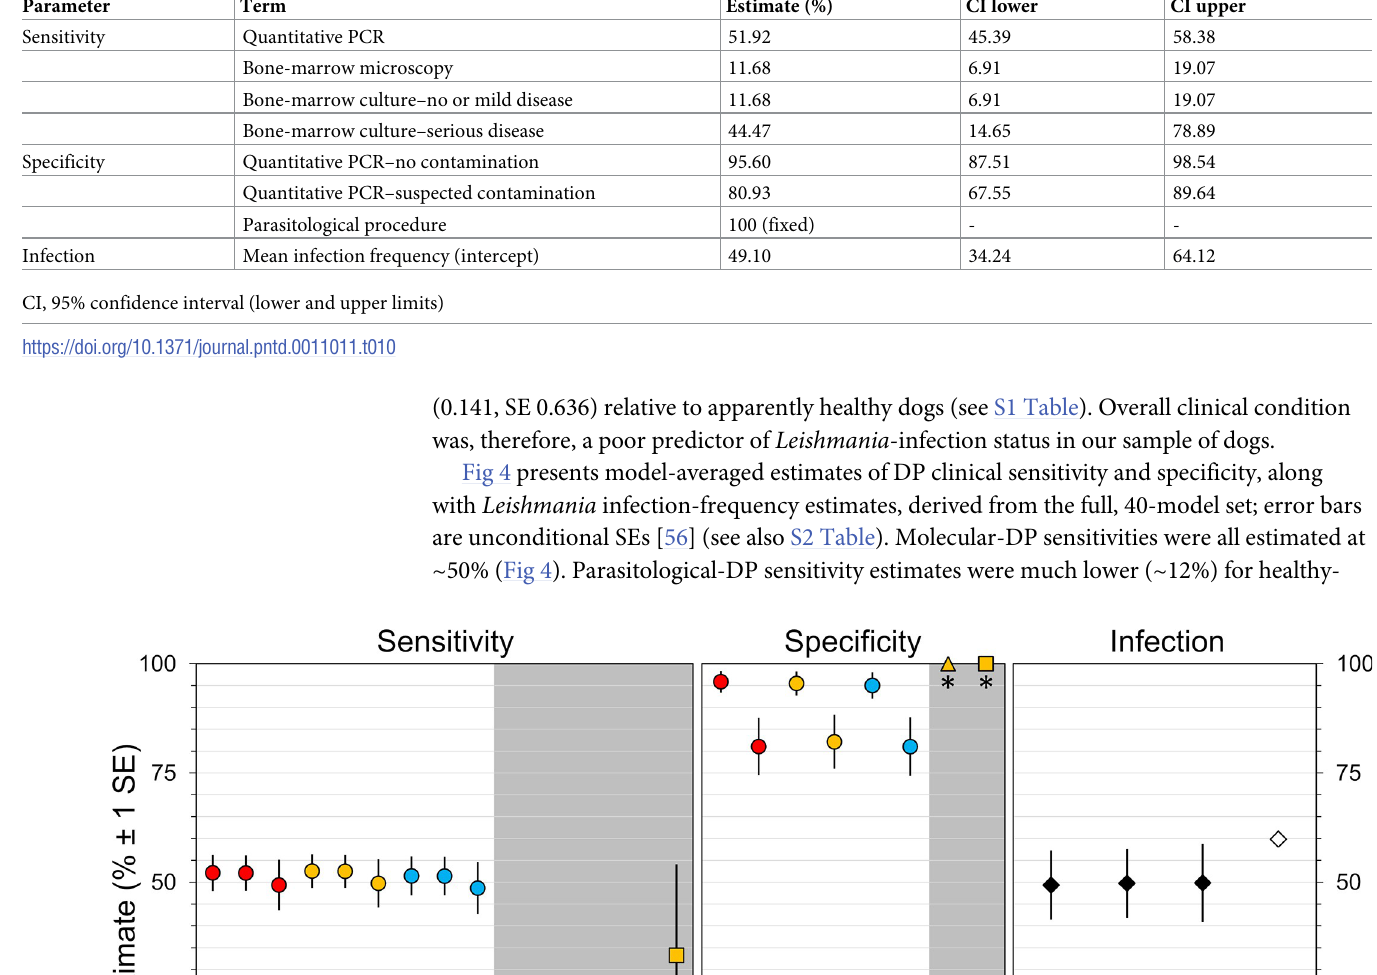
Table 10. Performance of diagnostic procedures for detecting Leishmania infection in dogs: Estimates from the top-ranking model (model {36}). Parameter